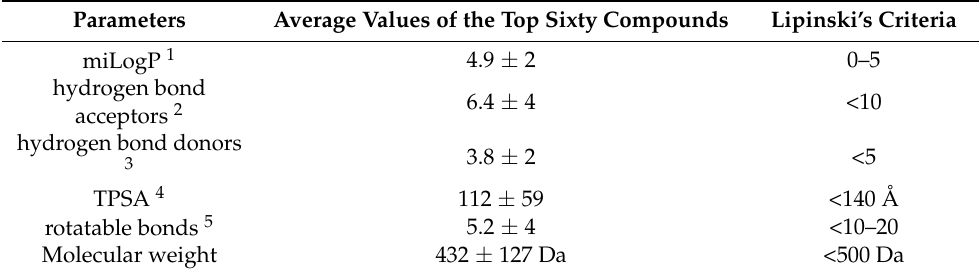
Table 16. Physicochemical properties of the sixty most potent MDLs obtained from PUBCHEM database.